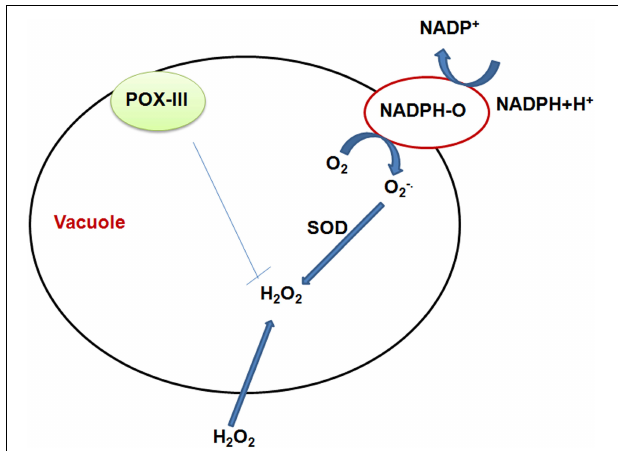
FIGURE 4 | Schematic representation of the vacuolar functioning of redox active enzymes, as well as sugars, namely fructans, acting in cooperation with peroxidases. T-tonoplast; POX-class III peroxidase; NADPH-O-NADPH oxidase; SOD-superoxide dismutase; Functioning in the vacuole of NADPH oxidase and superoxide dismutase is presently a hypothetical possibility, and the validity of this hypothesis is still an open